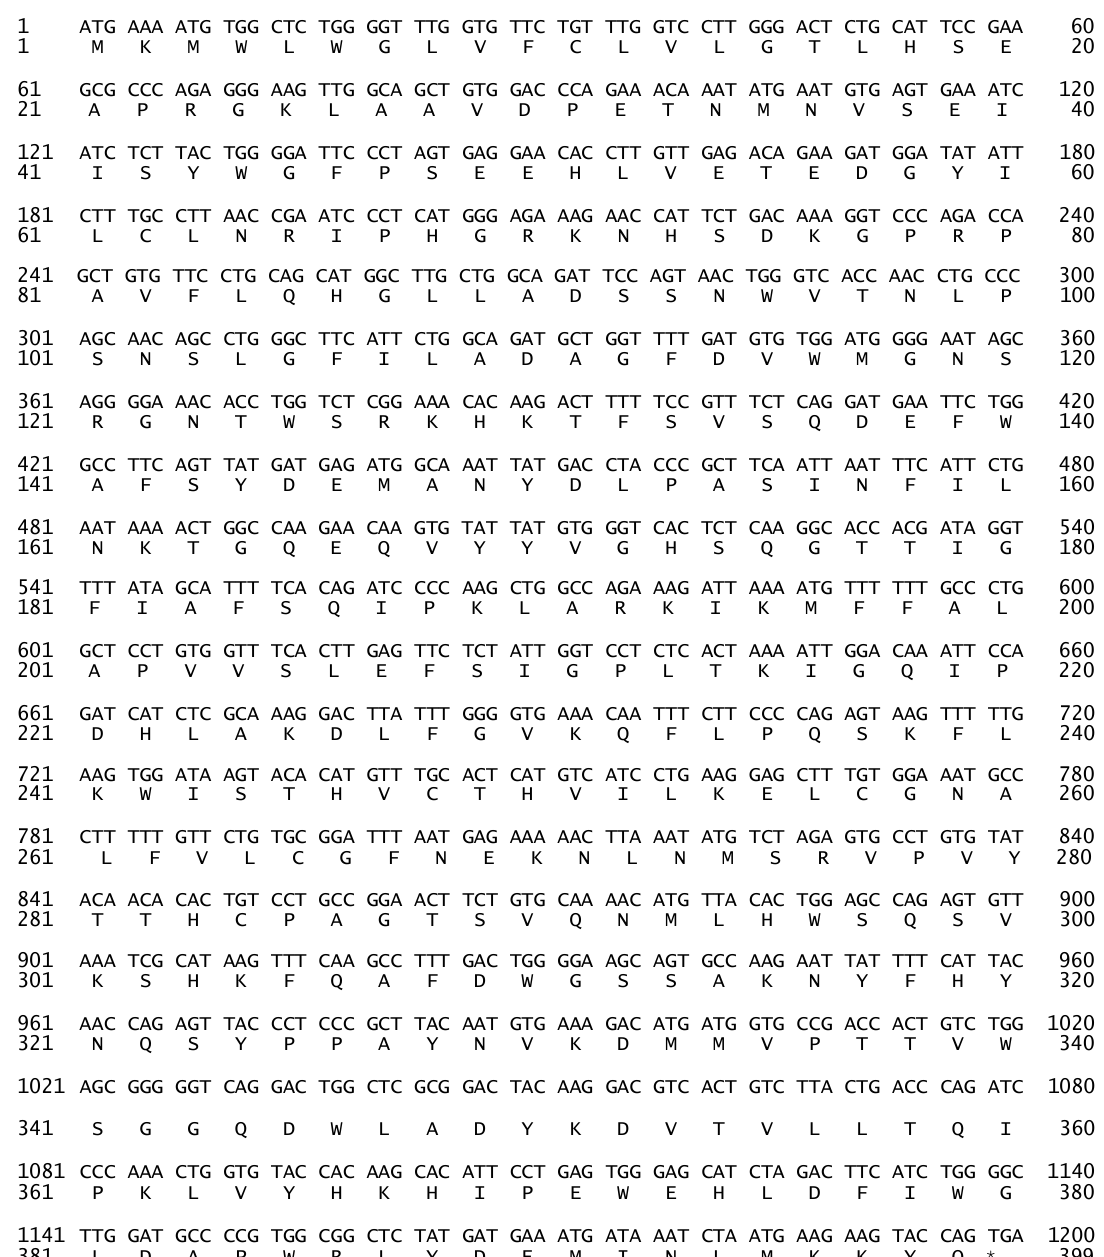
Figure 2. The nucleotide sequence and the deduced aminoacids of the cloned cLIPA . The sequences were submitted to NCBI GenBank (accession number JF803951 and AEG75815,